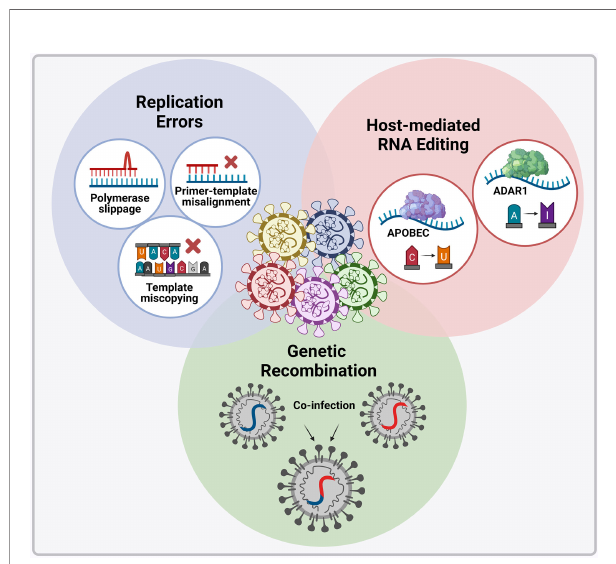
FIGURE 4 | Molecular mechanisms introducing genomic alterations into the SARS-CoV-2 genome. Nucleotide changes can emerge naturally in the viral genome through the various replication errors shown. Apart from replication errors, host-derived RNA editing enzymes apolipoprotein B mRNA editing catalytic polypeptide-like enzyme (APOBEC) and adenosine deaminase RNA speci fi c 1 enzyme (ADAR1) can introduce signature point substitutions [cytosine (C) to uracil (U) and adenosine (A) to inosine (I)] into the viral genome. Lastly, if two viral variants co-infect the same cell recombination can occur whereby the genetic material of the two variants are packages into a single virion. Image created by PM using BioRender